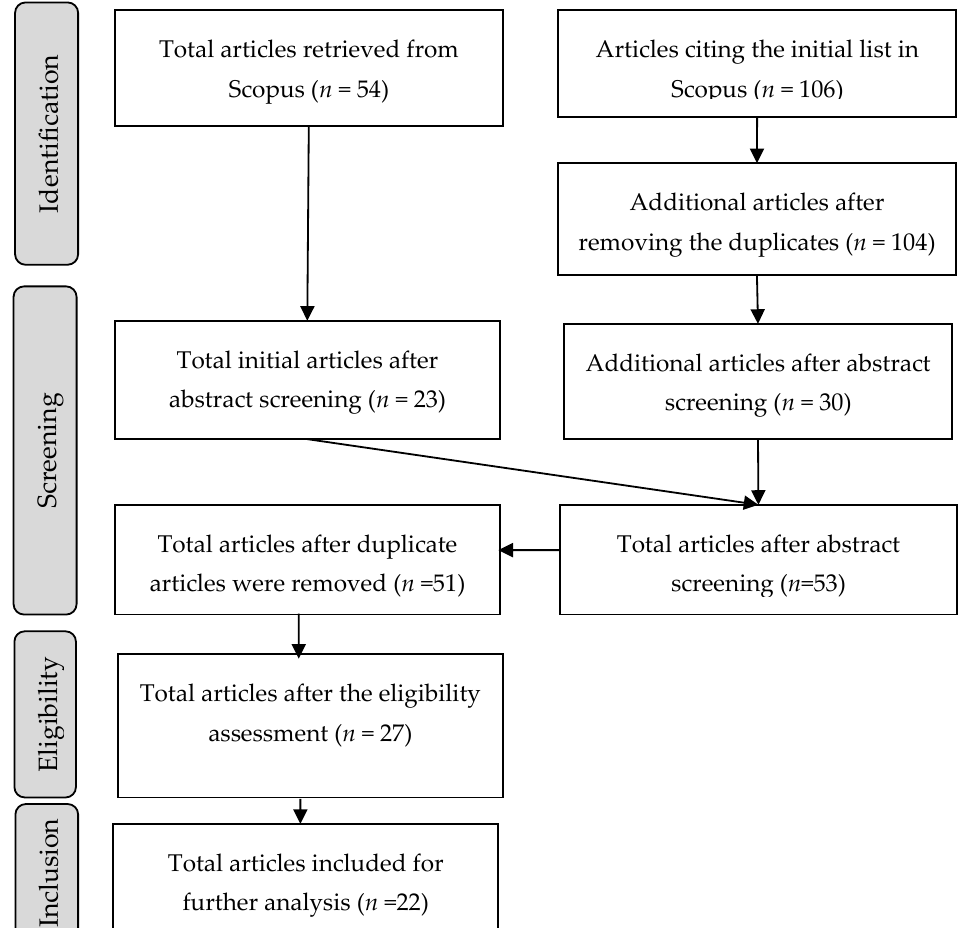
Figure 1. The systematic literature review procedure.